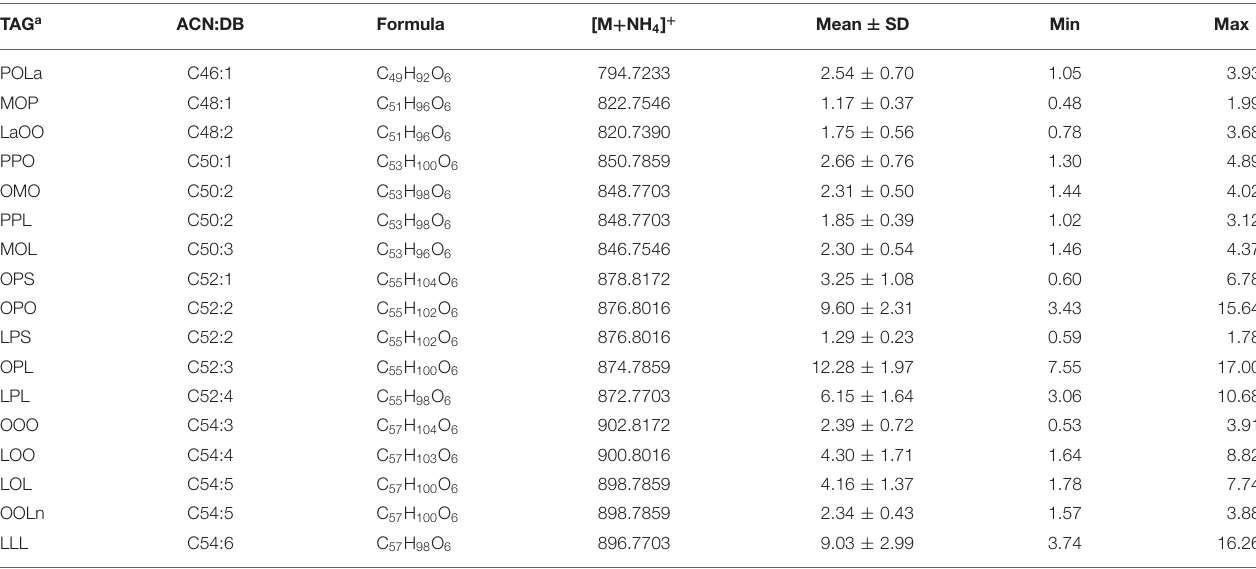
TABLE 3 | Triacylglycerol species in mature human